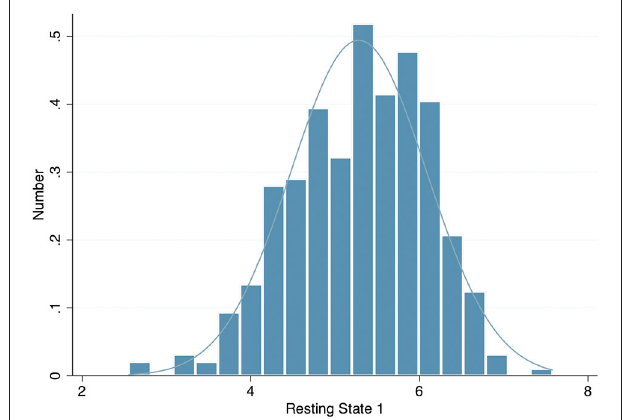
FIGURE 1 | Histogram of left eye resting pupil diameter in darkness.